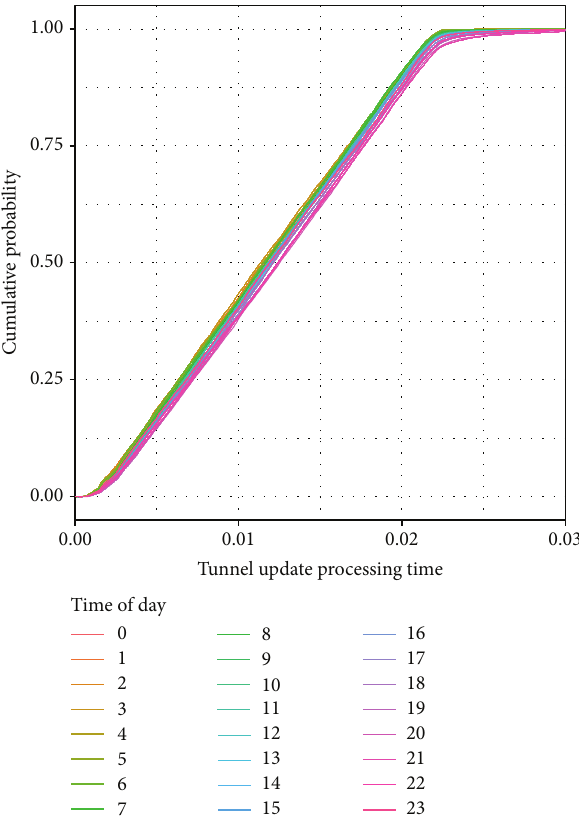
Figure 9: Empirical CDFs of the time it takes a GGSN to process a GTP update event, plotted for each hour of the day.